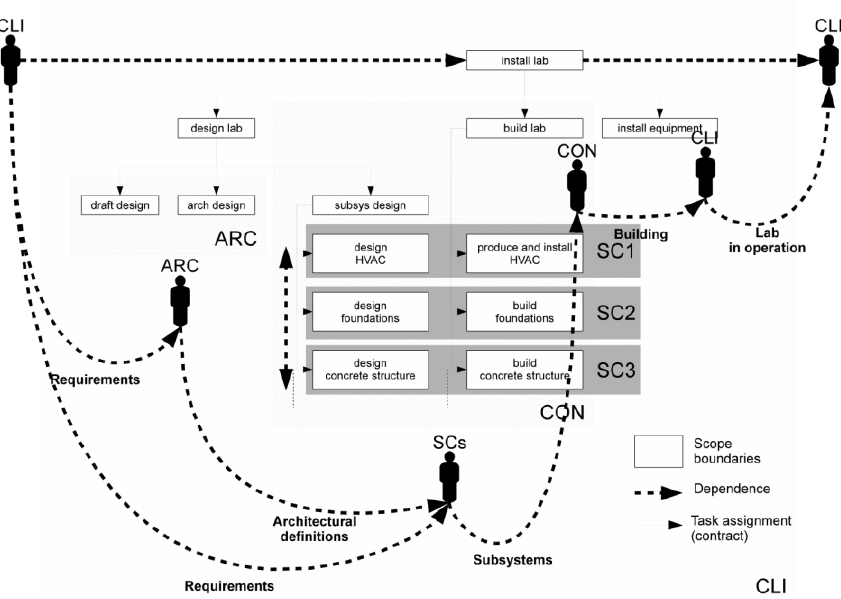
Figure 2 Decomposition of the project into subtasks and dependences between supply chain